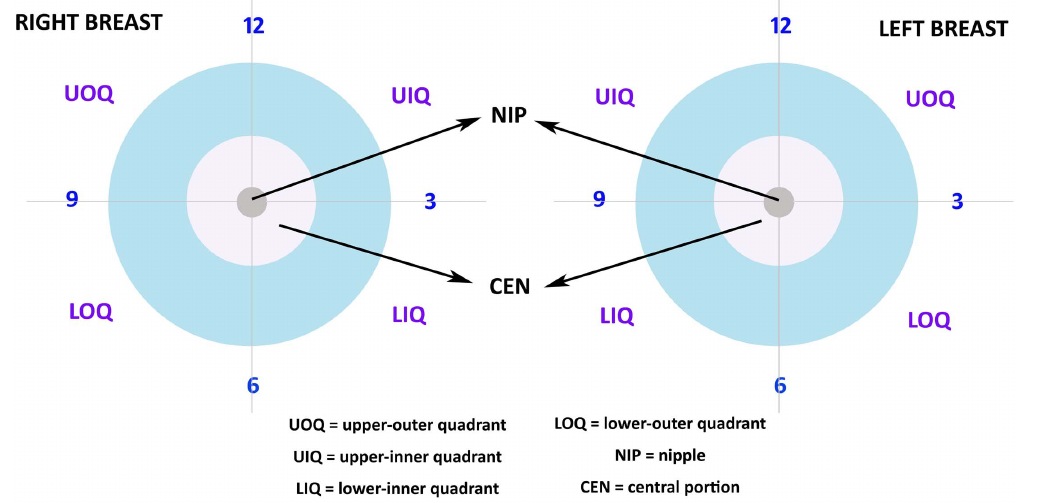
Figure 1. Classification of the Primary Breast Tumor Site. The primary breast tumor site is classified as five groups: upper outer quadrant (UOQ), upper inner quadrant (UIQ), lower inner quadrant (LIQ), lower outer quadrant (LOQ) and central portion